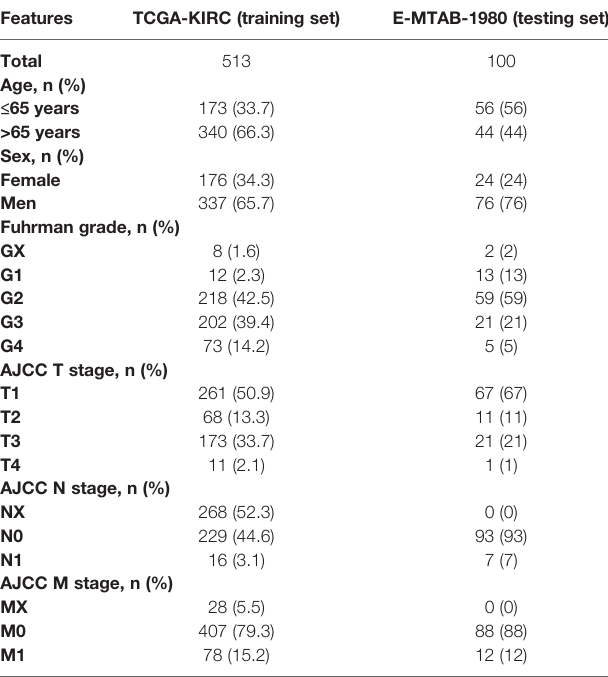
TABLE 1 | Clinical and pathologic features of eligible ccRCC patients from TCGA-KIRC and E-MTAB-1980. Features TCGA-KIRC (training